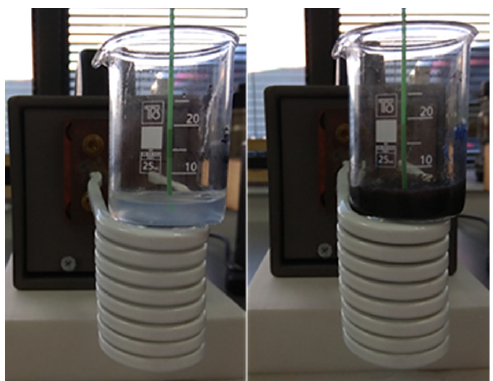
Figure 2. Experimental setup of PMF hyperthermia for HTP ( left ) and CTP ( right ) samples.